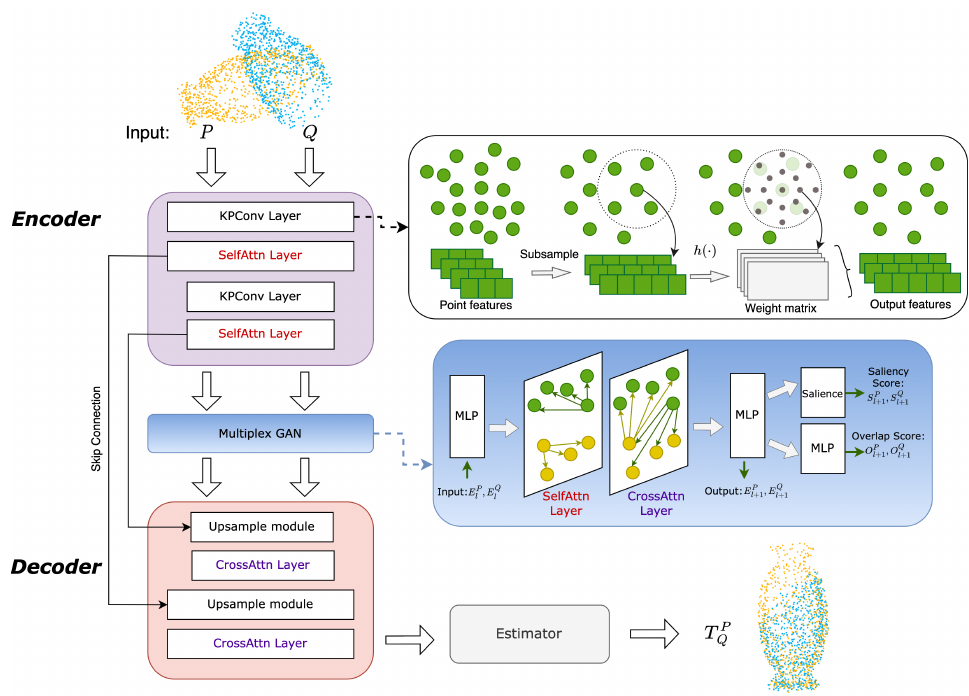
Figure 2. Architecture of the proposed